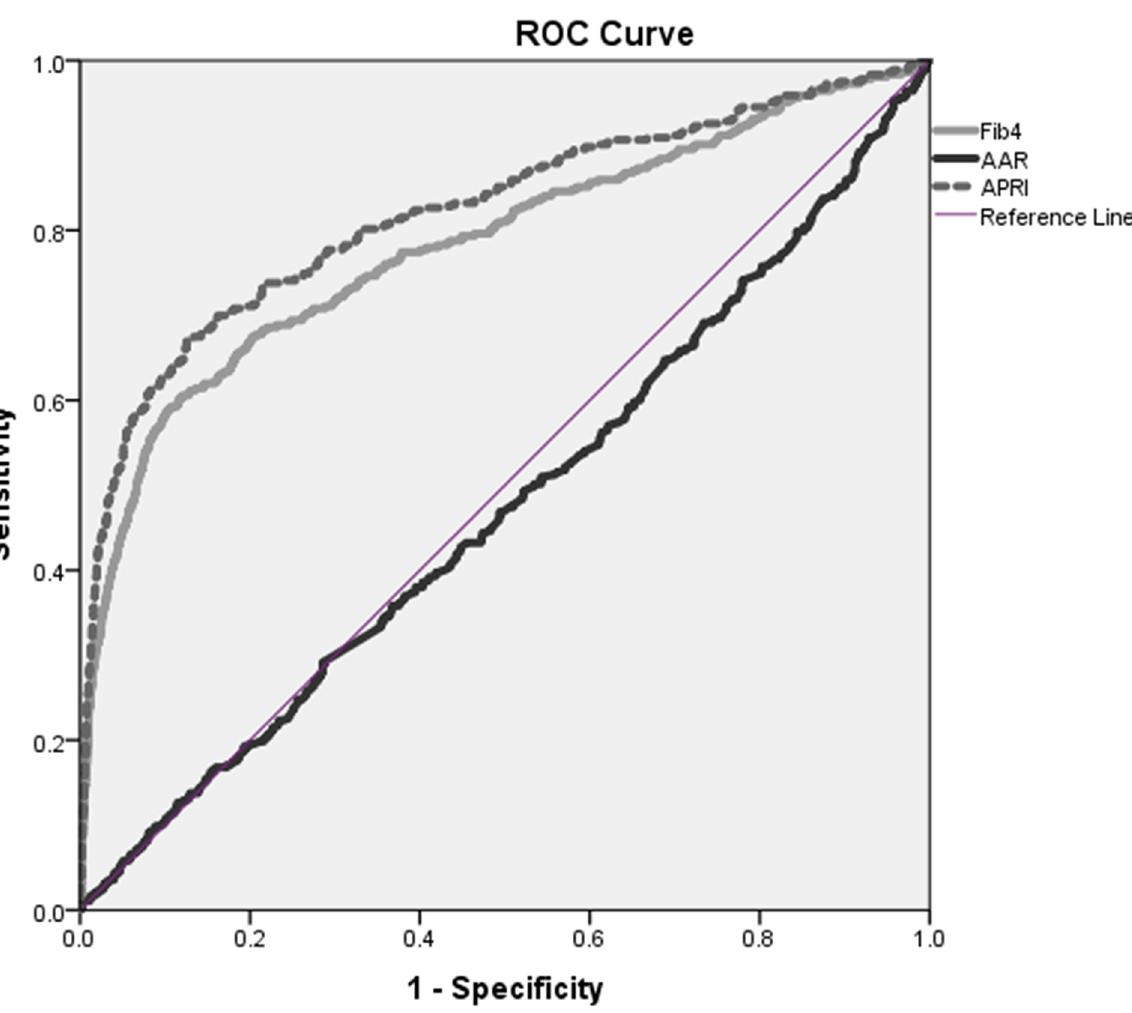
Fig 2. Area under the curve for results of the three fibrosis tests.